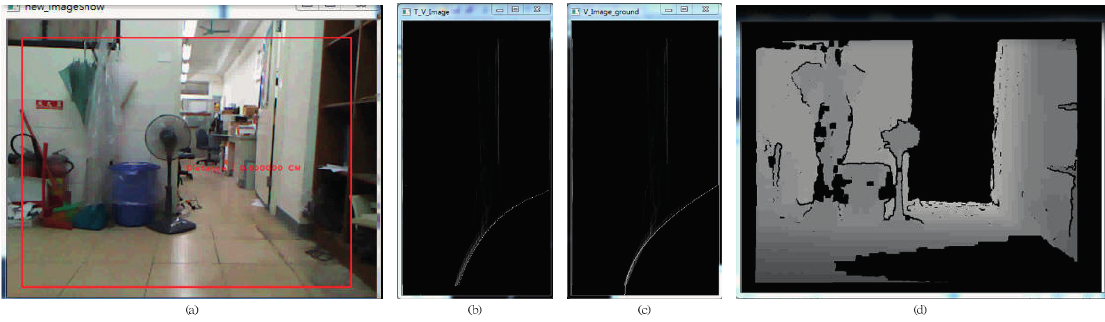
Figure 9. No offset. ( a ) Real scene; ( b ) No LSM Curve; ( c ) LSM Curve without offset; ( d ) Depth map.